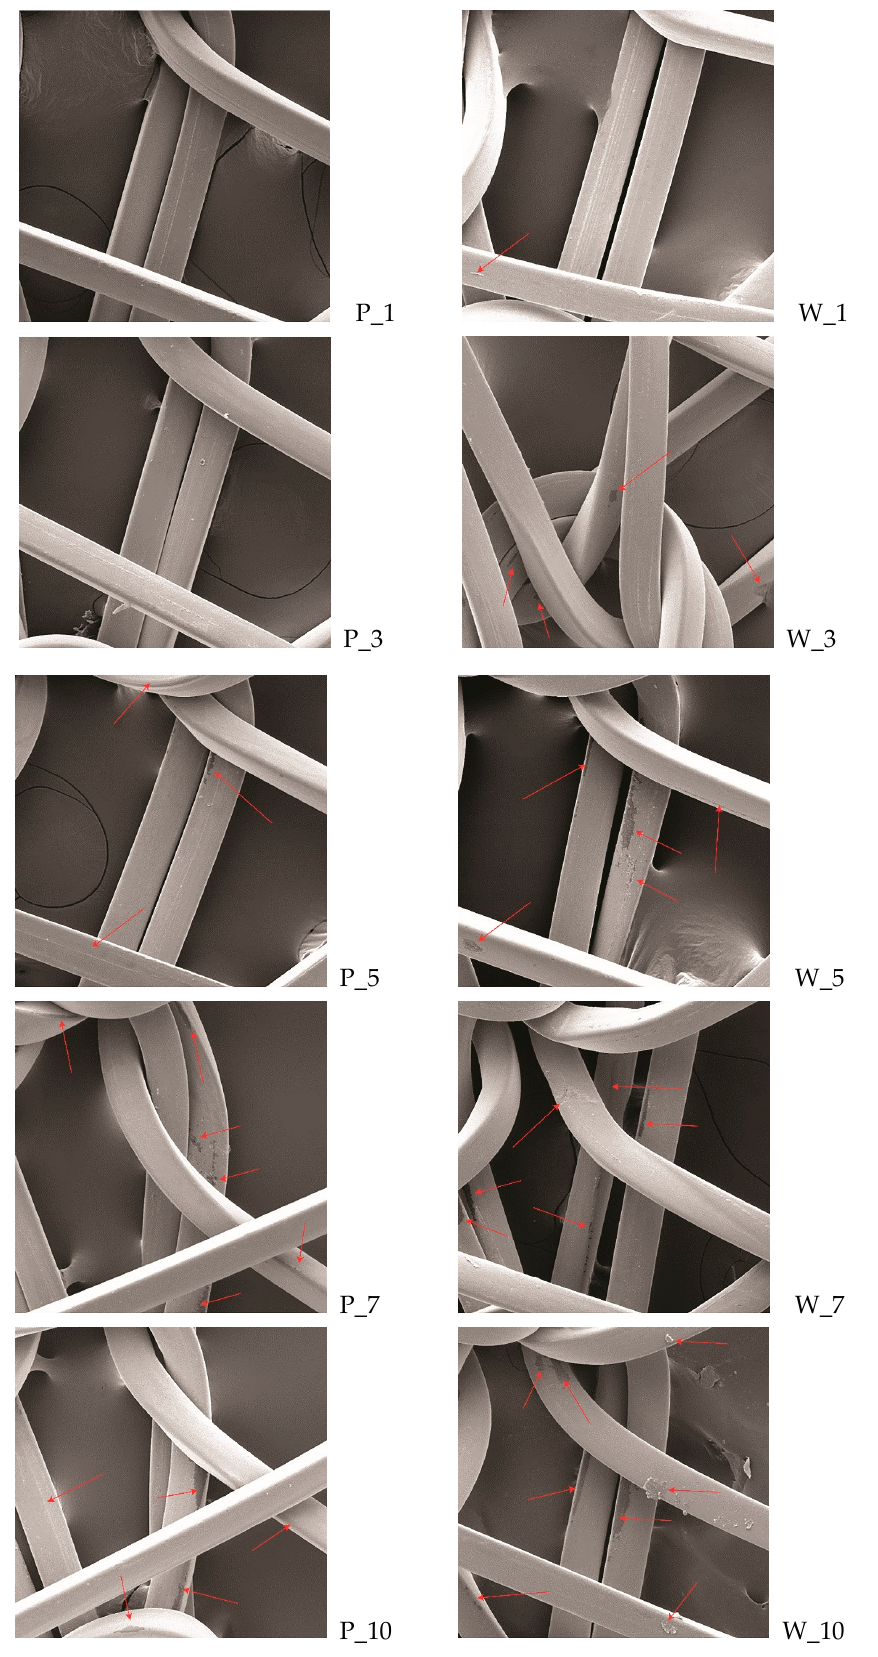
Figure 5. SEM micrographs of the PA/Ag samples before and after the 1st, 3rd, 5th, 7th and 10th treatment cycles of dry (P) and wet cleaning (W), under a magnification of 500×. The influence of the apolar solvent (P) in synergy with the dry cleaning process pa- rameters could be seen after five cycles, which can be attributed to the successive cycles. With the increase in the number of cycles on the knitted fabric, greater longitudinal dam- age of the silver coating on the threads was noticed, which intensified in the 10th cycle. The irregular shape of the damage and the appearance of ruptures on the silver coating indicate a more intense influence of mechanics as a process factor, which led to fractures of the material. Such local damage excludes the influence of solvents, which would act more evenly over the entire surface. The changes in the surface of the PA/Ag fabric under the influence of the polar solvent (W) and wet cleaning process parameters were visible after the 3rd cycle. The change dynamics were more intense compared to the dry cleaning (P). Additionally, irregular incrustations could be seen on the sample surface after 10 cy- cles of wet cleaning (W_10), which indicate the interaction of some of the substances in the process. The SEM images indicate that the polar solvent, in synergy with the process parameters of wet cleaning, caused a higher degree of longitudinal and irregular local damage to the PA/Ag fabric compared to the apolar solvent and the process parameters of dry cleaning. The examination of the durability of the protective properties of elastic yarns with metal coatings has confirmed that the changes in the conductive properties during wash-